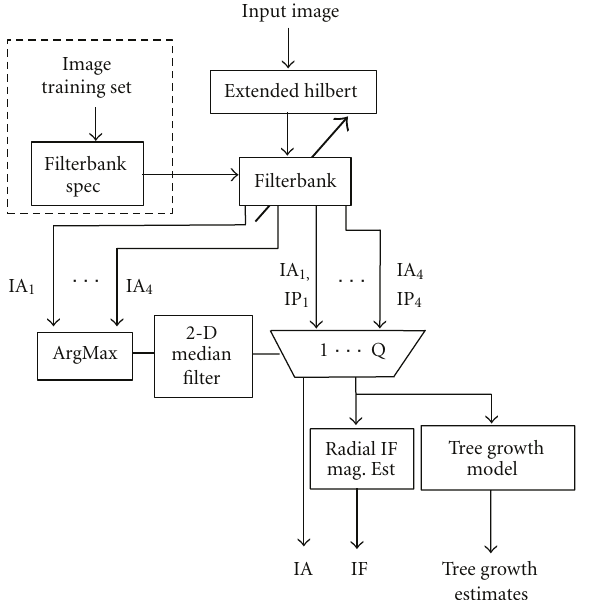
Figure 2: Tree image growth analysis system diagram. Here, IA denotes the instantaneous amplitude, IP denotes the instantaneous phase, and IF denotes the instantaneous frequency.